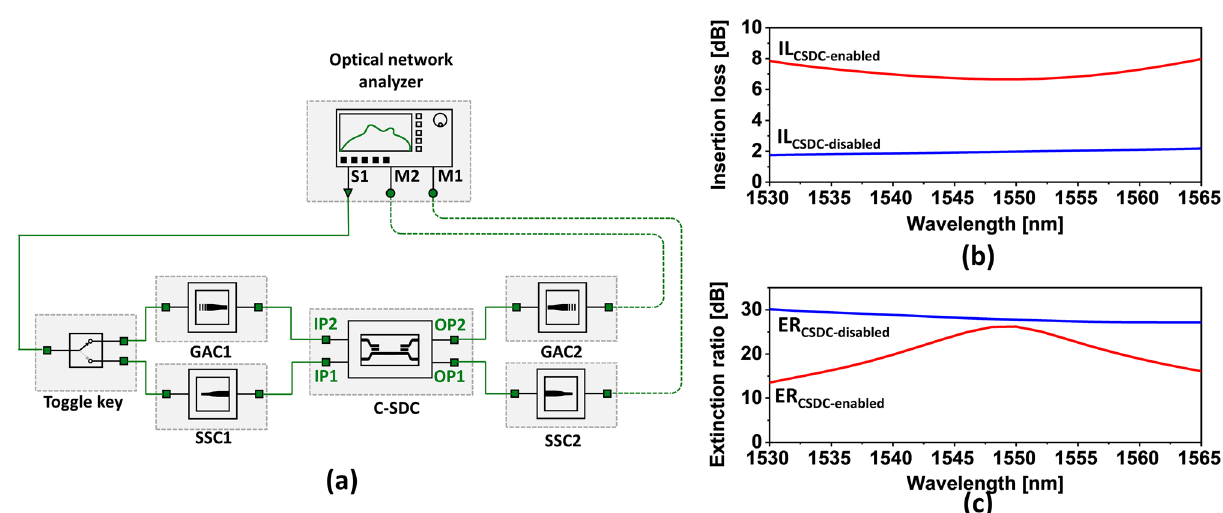
Figure 8. ( a ) Schematic layout portraying a complete RFWC module under simulation in which all functional blocks including the proposed GACs, SSCs and C-SDC are deployed. An optical network analyzer having a light source (S1) and two power monitor terminals (M1 and M2) is used to monitor the spectral transmission of the circuit. ( b ) Calculated IL spectra using the transmitted power recorded at the monitors M1 and M2 for both the cases of C-SDC enabled and disabled. ( c ) Calculated ERs of the circuit as observed at M1 and M2 of the analyzer, for the C-SDC-enabled case with the input/output through the GACs, and the case of disabled C-SDC with the input/output via the